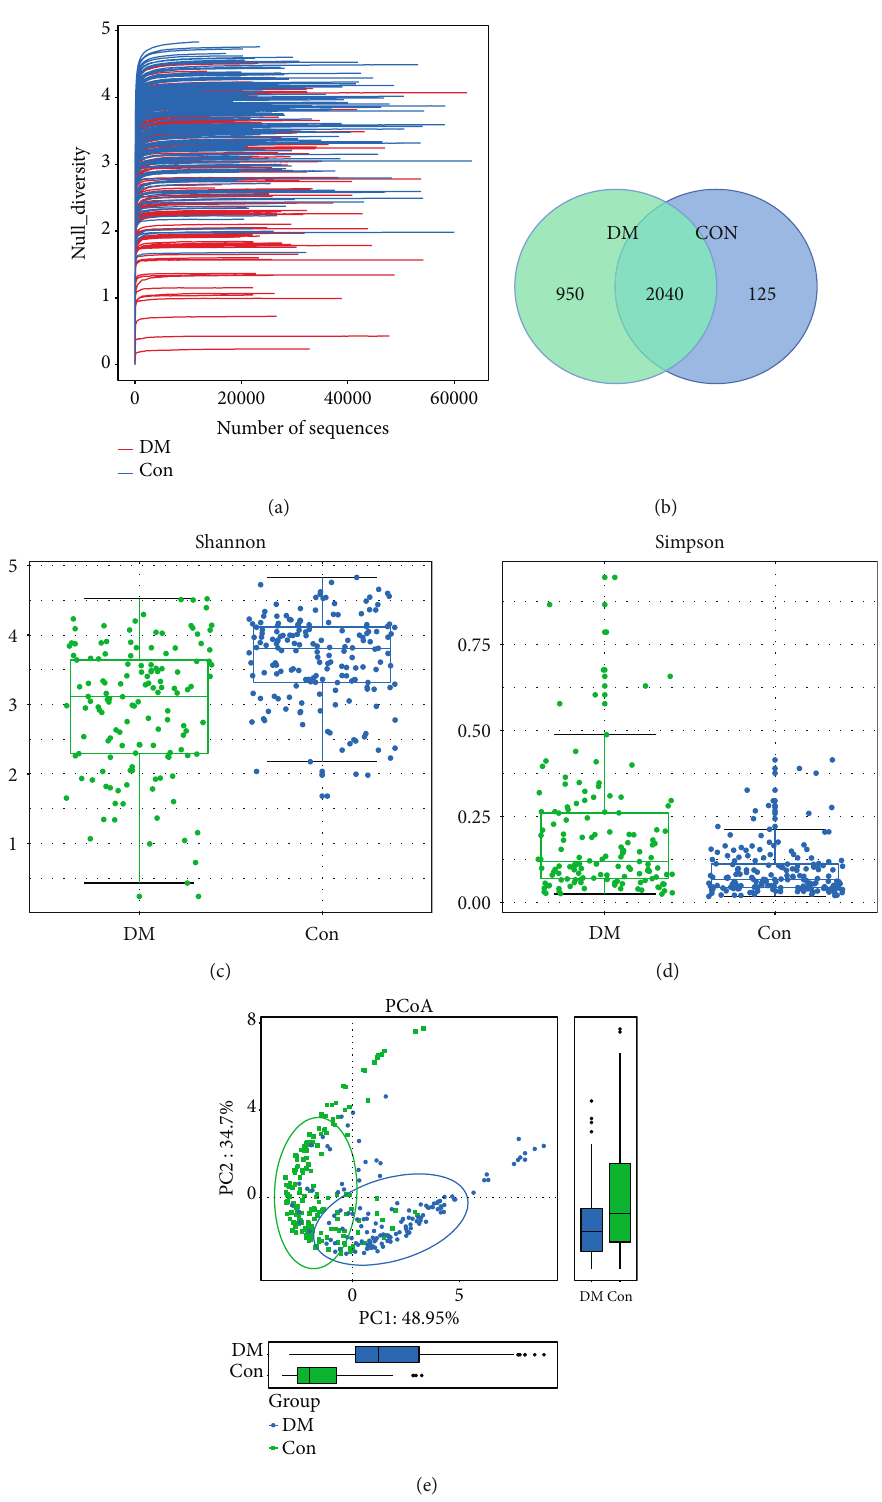
Figure 1: Comparison of microbial diversity and species composition between DM ( n = 137 ) and Con ( n = 179 ). (a) Shannon-Wiener curves showing estimated OTU richness basically approached saturation in all samples, and the microbial diversity was lower in the DM group. (b) Venn diagrams showing OTU distribution in di ff erent groups. (c, d) Estimated by the Shannon and Simpson index α -diversity in the DM or Con group. (e) Based on weighted UniFrac algorithm, β -diversity was visualized among the two groups in way of PCoA. DM: diabetes mellitus; Con: control group; OTUs: operational taxonomic units; PCoA: principal coordinate